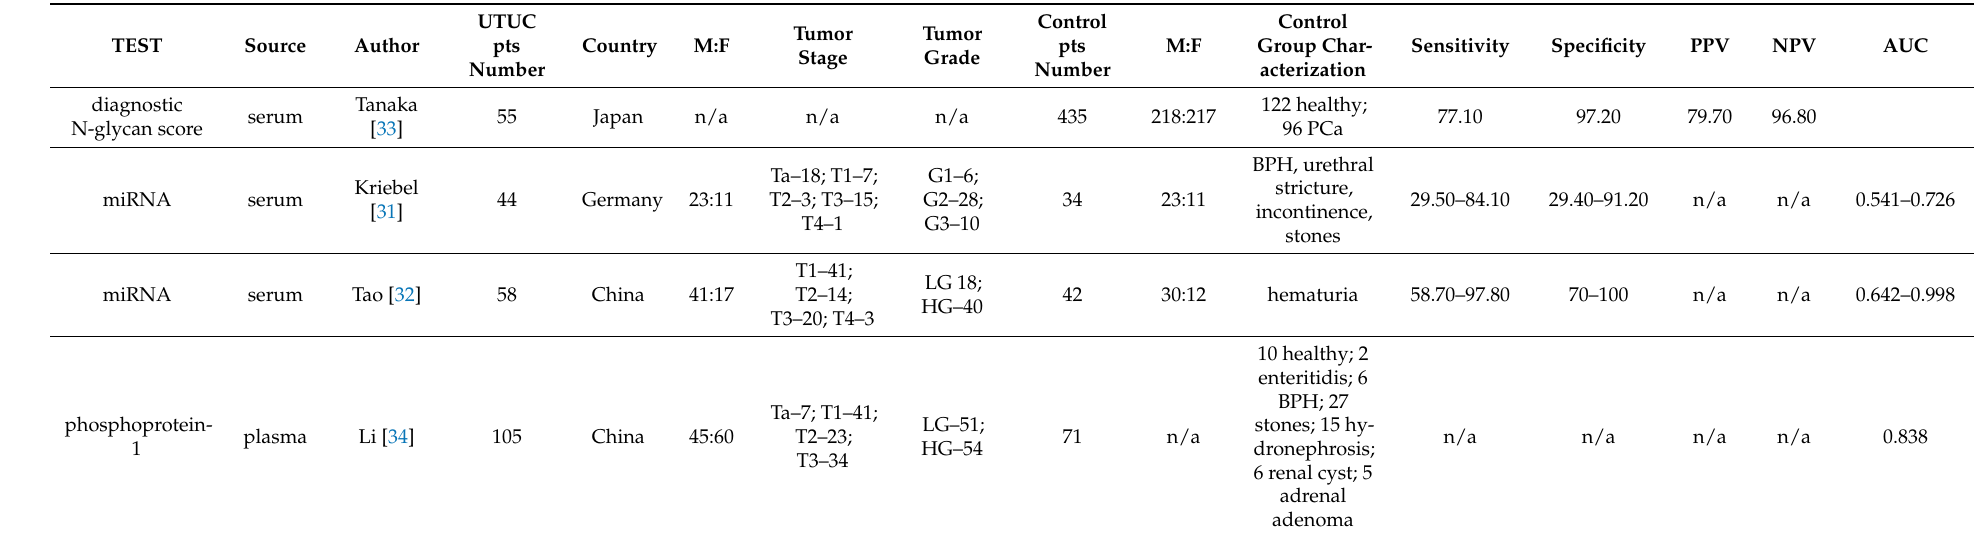
Table 4. The performance of blood-based tests in the diagnosis of